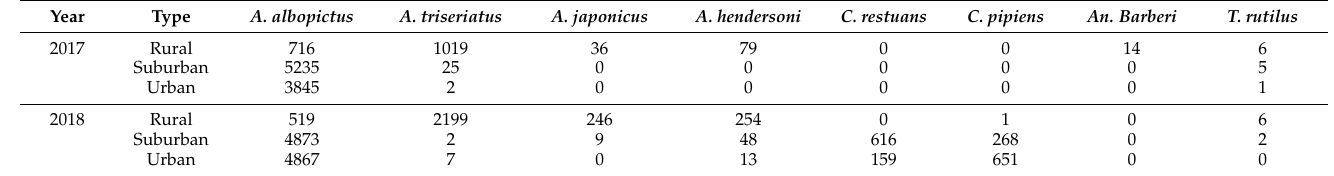
Table 1. The number of each species collected over the entire sampling period by land use type and